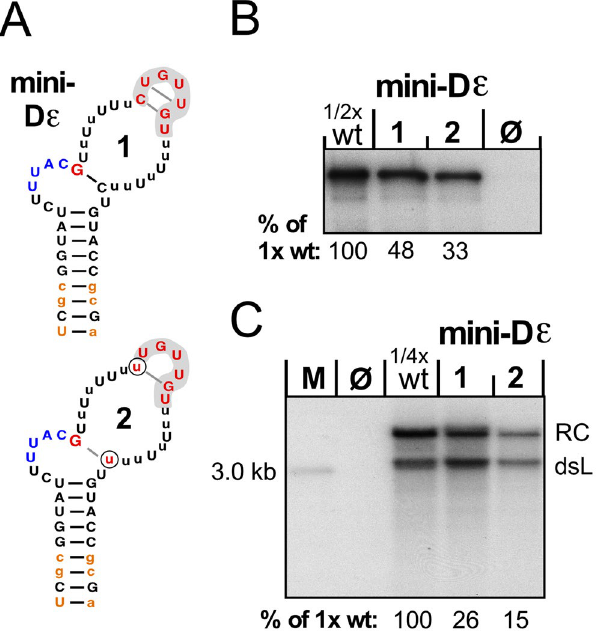
Figure 8. The GUUGU motif and the G following the bulge maintain functionality in the absence of a defined structure context. ( A ) Sequences of mini-D ε 1 and mini-D ε 2 RNAs. The two U residues distinguishing mini-D ε 2 from mini-D ε 1 are encircled. Lower case lettering indicates non-wt nt; those shown in orange in the lower stem were present in the RNAs used for in vitro priming but not in the mini-D ε pCD16_ Δ 3 ′ε vectors used to assess replication competence. ( B ) Mini-D ε in vitro priming activity. In vitro transcribed mini-D ε RNAs were subjected to miniDP priming assays with dGTP, in parallel with controls without RNA (ø) and with wt-D ε RNA; of the latter sample, only half as much of the reaction was loaded (1/2 wt). Signals were quantified by phosphorimaging and those of the variants were related to twice the intensity (set as 100%) of the 1/2 wt signal. ( C ) Mini-D ε 1 and mini-D ε 2 support DHBV replication. LMH cells were transfected with wt-DHBV vector pCD16_ Δ 3 ′ε or derivatives carrying mini-D ε 1 and mini-D ε 2 at the 5 ′ ε position. DNA from cytoplasmic nucleocapsids was analyzed by Southern blotting using a 32 P-labeled DHBV DNA